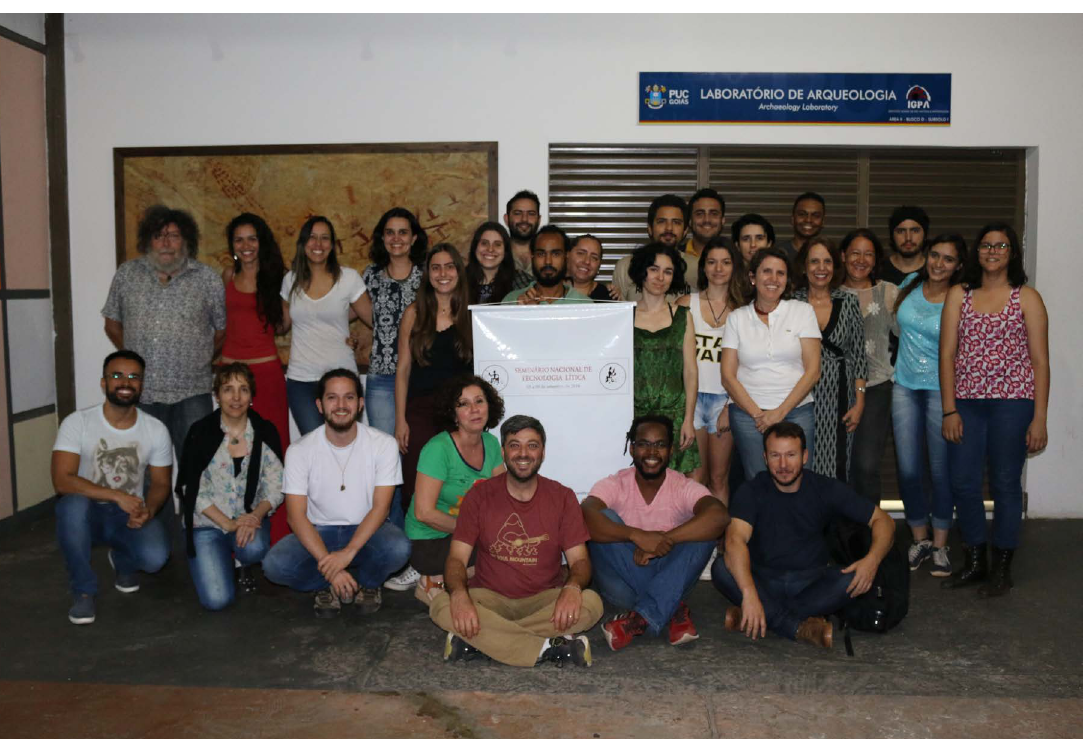
Figure 2. Participants and organizing team of Seminário Nacional de Tecnologia Lítica. (Photograph by Lorena Borges,